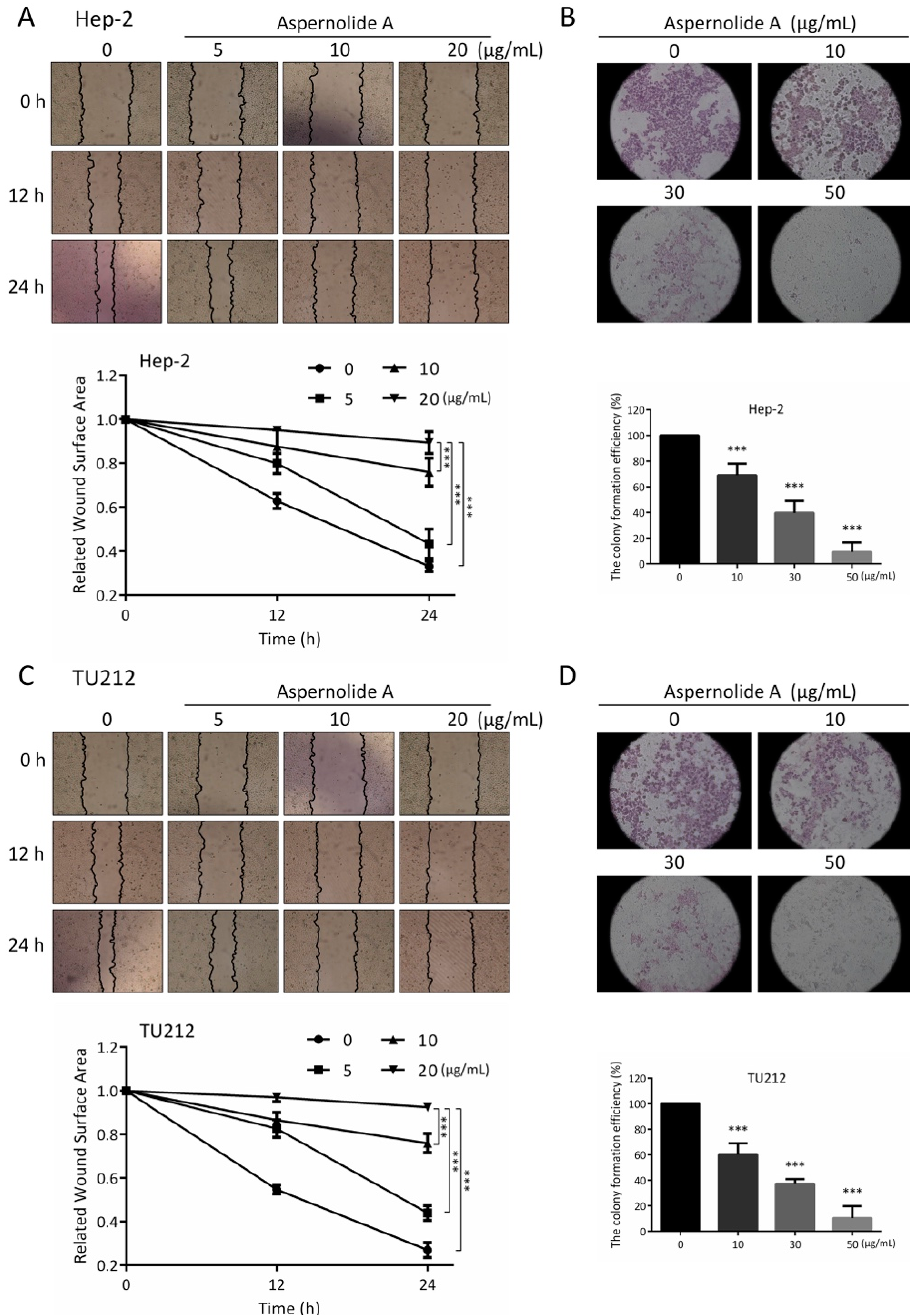
Figure 3. Cell migration and colony-forming in Hep-2 and TU212 cells with aspernolide A. ( A , C ) Representative images of scratch assay and its counting results. ( B , D ) Representative images of colony-forming assay and their counting results. (* p < 0.05, ** p < 0.01 or *** p < 0.001).